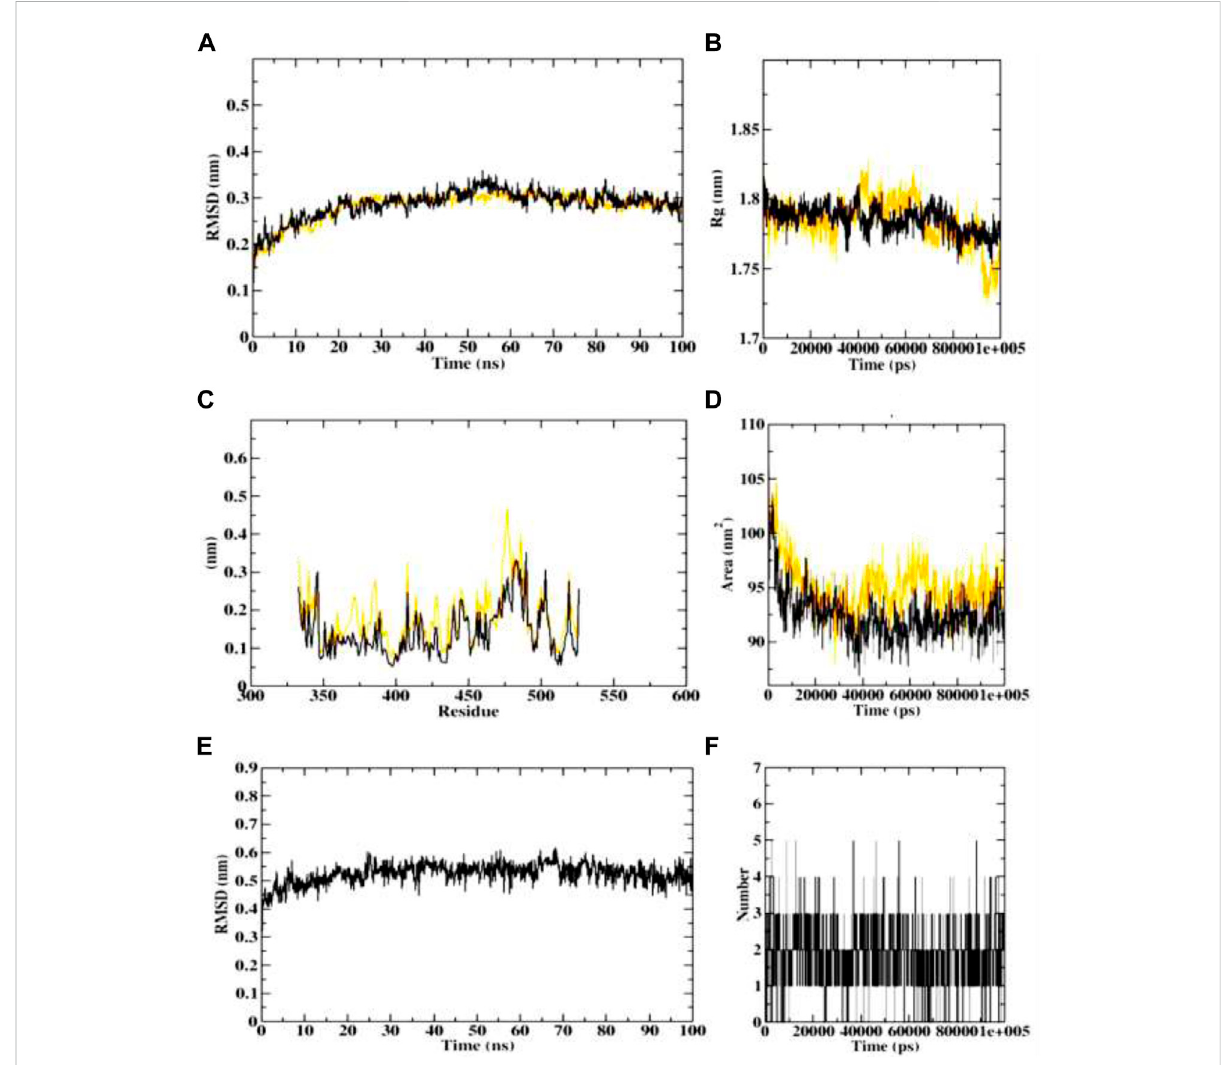
FIGURE 13 Visualization of MD trajectories of dehydronimodipine complexed with 4EY7 Run for 100 ns (A) protein-ligand complex RMSD, (B) protein- ligand complex Rg, (C) protein-ligand complex RMSF, (D) protein-ligand complex SASA, (E) ligand RMSD, (F) ligand hydrogen bonds. (red: protein backbone atoms, black: protein-ligand